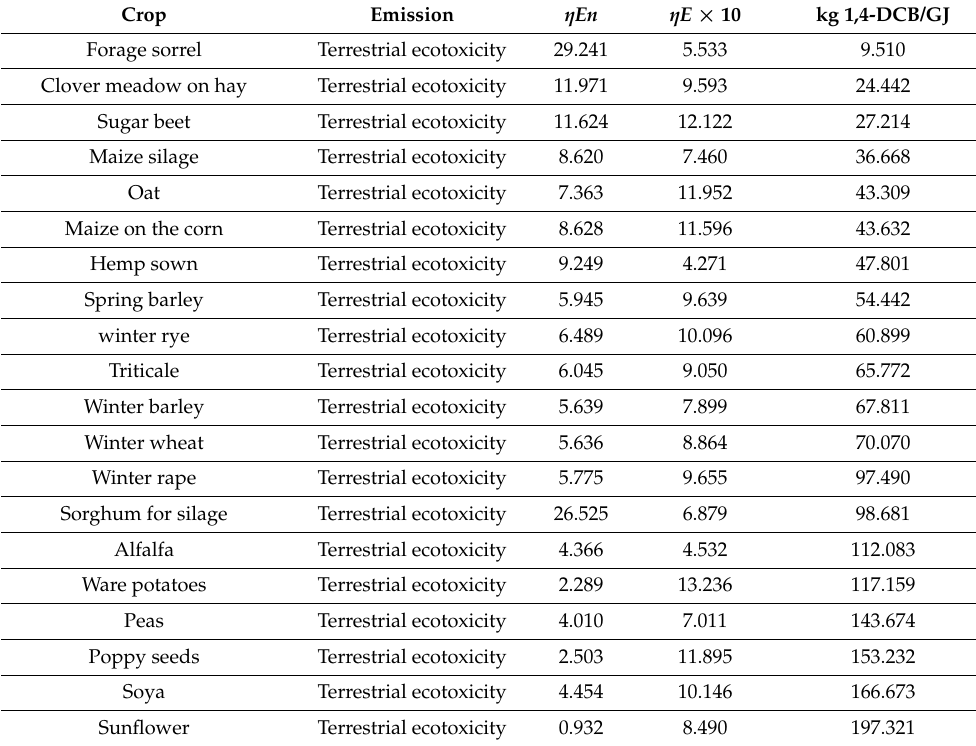
Table A9. Average emissions of terrestrial ecotoxicity and efficiency of